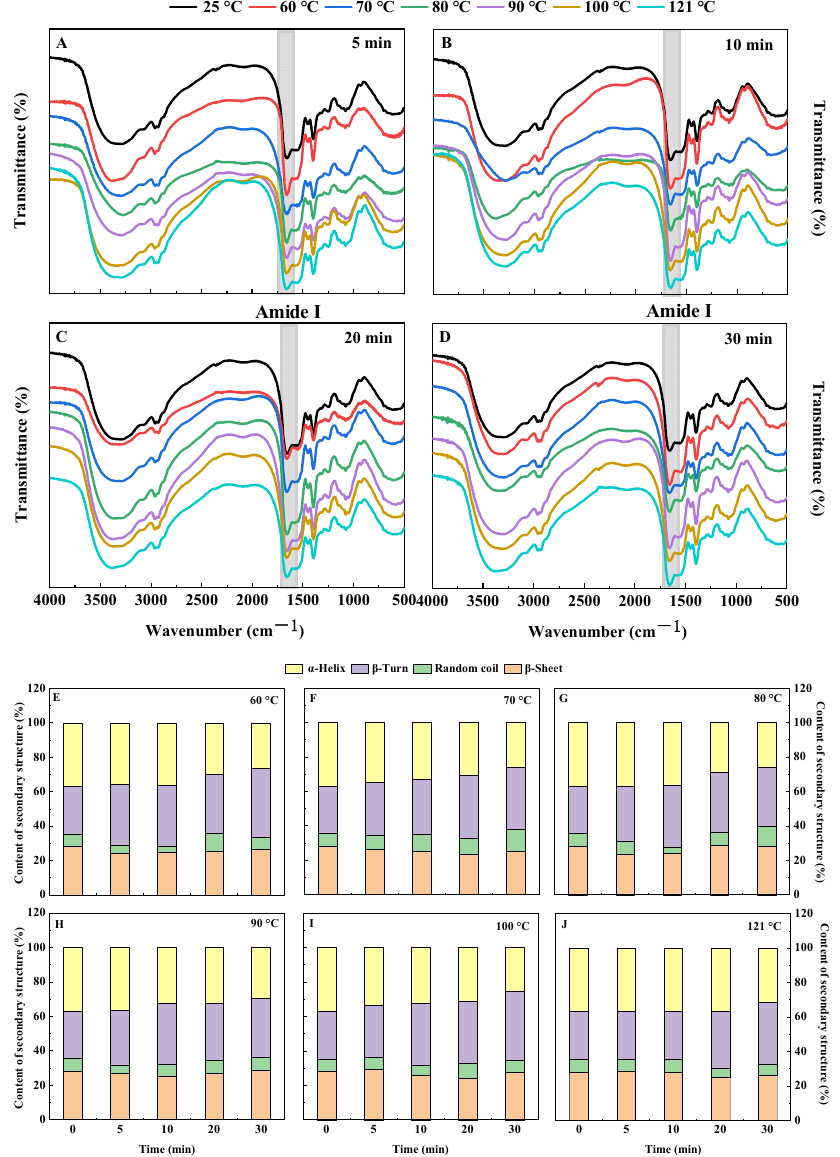
Figure 5. Effects of hydrothermal treatment of 5 min ( A ), 10 min ( B ), 20 min ( C ), and 30 min ( D ) on the Fourier infrared spectrum of QPI, 60 °C ( E ), 70 °C ( F ), 80 °C ( G ), 90 °C ( H ), 100 °C ( I ) and 121 °C ( J ) on the relative content of the secondary structure of QPI.